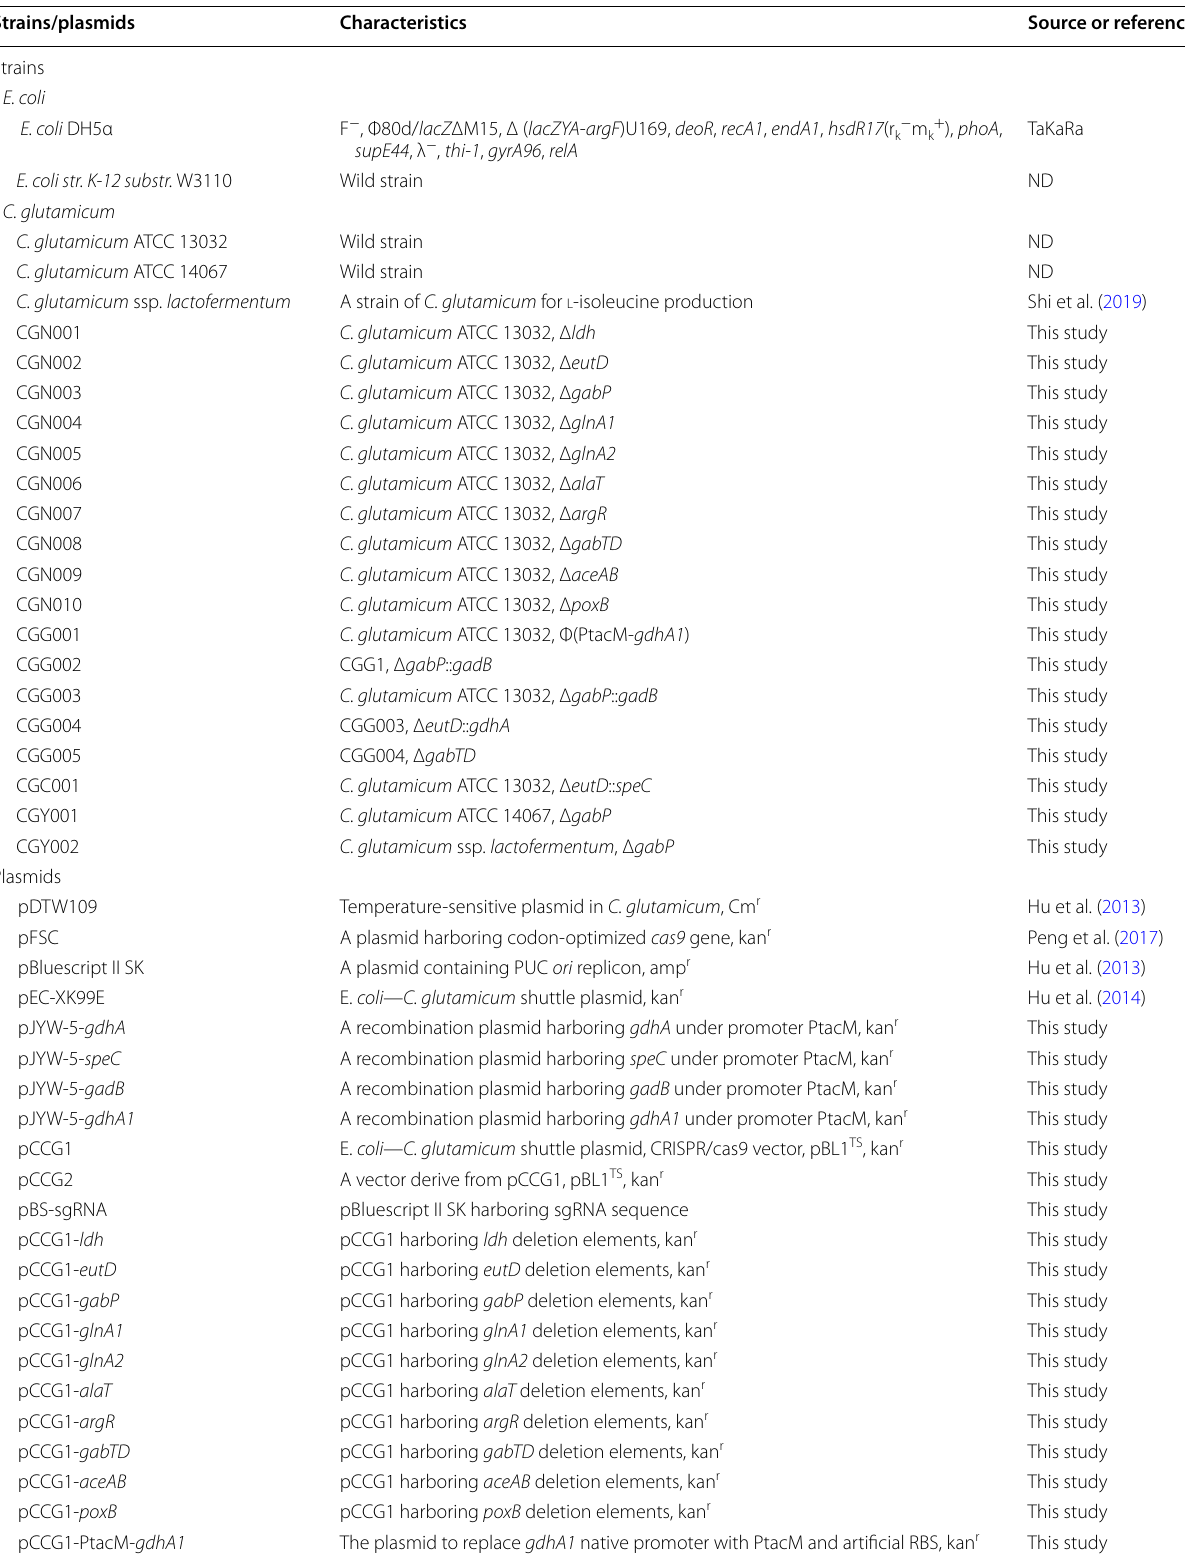
Table 1 Bacterial strains and plasmids used in this study Strains/plasmids Characteristics Source or reference